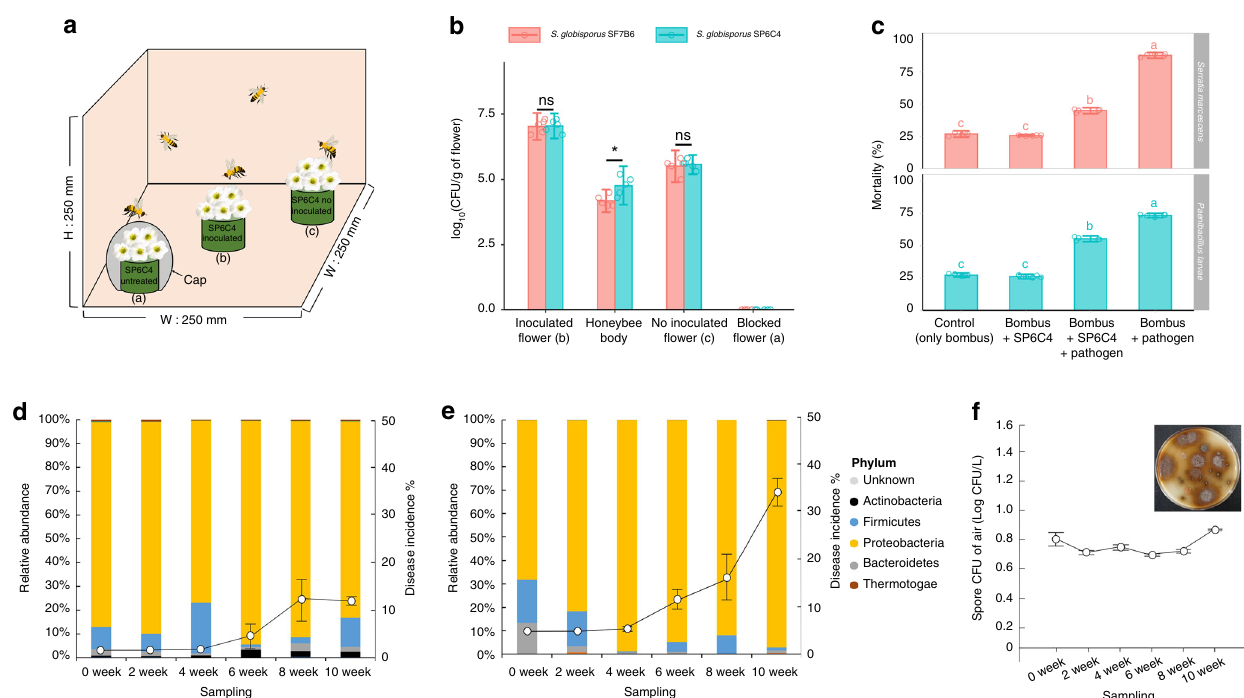
Fig. 5 S. globisporus SP6C4 dispersed from fl ower to fl ower, reduced insect mortality and incidence of gray mold. a Illustration of honeybee transport of SP6C4 from plant to plant. (a): SP6C4 untreated and honeybee access blocked by a cap, (b): fl ower stamens and carpels inoculated with a suspension (100 μ L) of SP6C4 (10 6 cfu/mL), (c): SP6C4 untreated fl ower ( n = 5, 3 independent experiments). b Population densities of SF7B6 and SP6C4 on fl owers and honeybee bodies. Surface bacteria were detached by sonication for 30 mins at 35 kHz. Streptomyces strain was isolated on PDK media amended with hygromycin B (80 µ g/mL). SF7B6 and SP6C4 treatments were analyzed by independent two sample t -test, * P < 0.05; inoculated fl ower: P = 0.9025, honeybee body: P = 0.0212, no inoculated fl ower: P = 0.7141. Bars represent standard deviation. c Mortality of Bombus impatiens . Entomopathogens (10 5 cfu/mL) were added with or without SP6C4 (10 6 cfu/mL) to pollen. Bars with different letters are signi fi cantly different according to Duncan ’ s test